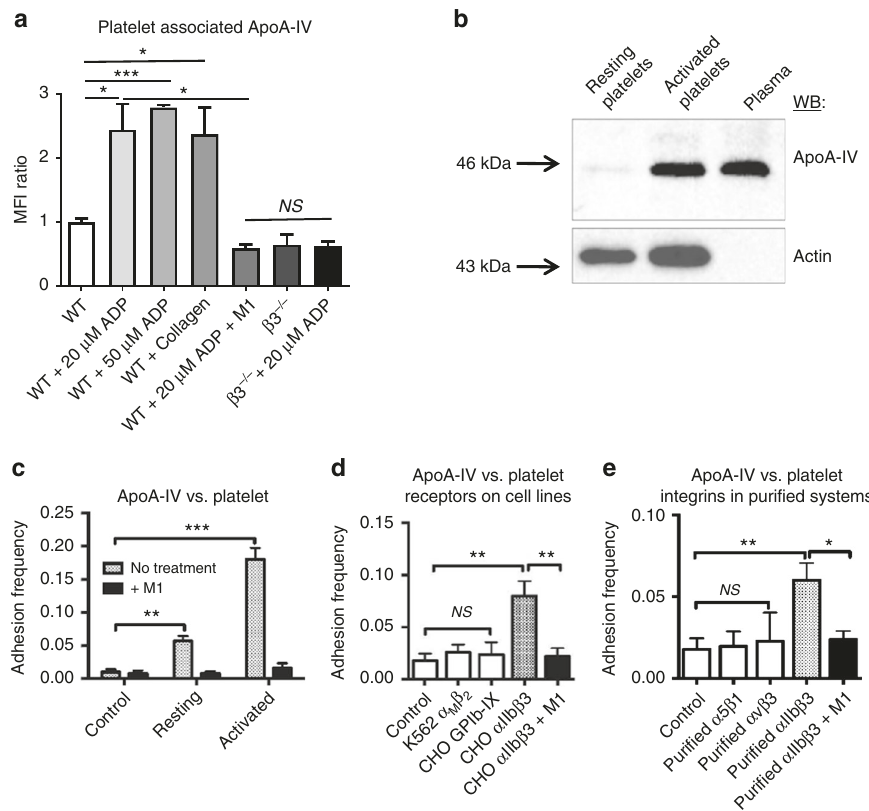
Fig. 1 ApoA-IV is a novel ligand of α IIb β 3 integrin. a Flow cytometry detection of apoA-IV on activated wild-type platelets ( n = 4). b Western blot detection of plasma apoA-IV on activated platelets ( n = 4, Supplementary Fig. 16). c – e Biomembrane Force Probe adhesion frequency assays. ApoA-IV bound to activated platelets with high frequency and interacted minimally with resting platelets ( c ), bound to CHO cells that express α IIb β 3, but not to the cell lines that express GPIb-IX or α M β 2 integrin ( d ) and bound to puri fi ed α IIb β 3, but not α V β 3 and α 5 β 1 integrins ( e ). Complete inhibition by mAb M1 was indicated. BSA was used as control ( n = 50 for each bead/target pair, >3 pairs per bar or data point for c – e ). WT wild-type, WB western blot, MFI mean fl uorescence intensity, M1 a speci fi c anti- β 3 integrin monoclonal antibody, β 3 − / − β 3 integrin-de fi cient, CHO Chinese hamster ovary. Unpaired, two-tailed Student ’ s t -test. Mean± SEM. NS not signi fi cant, * P < 0.05, ** P < 0.01 and *** P <